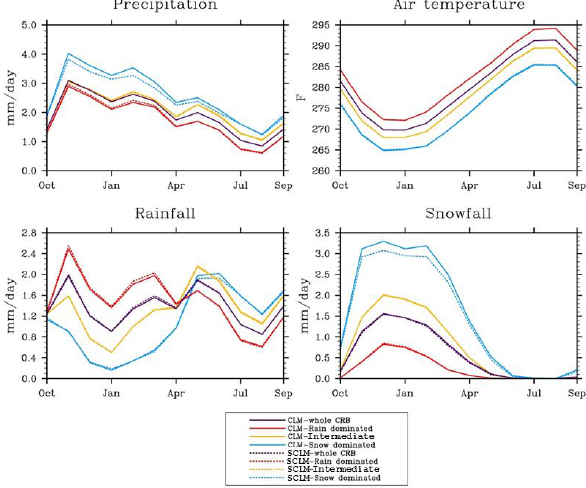
Figure 6. Seasonality of forcing over the climate regions.